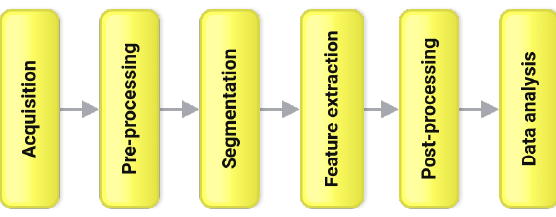
Figure 1. The standard workflow in